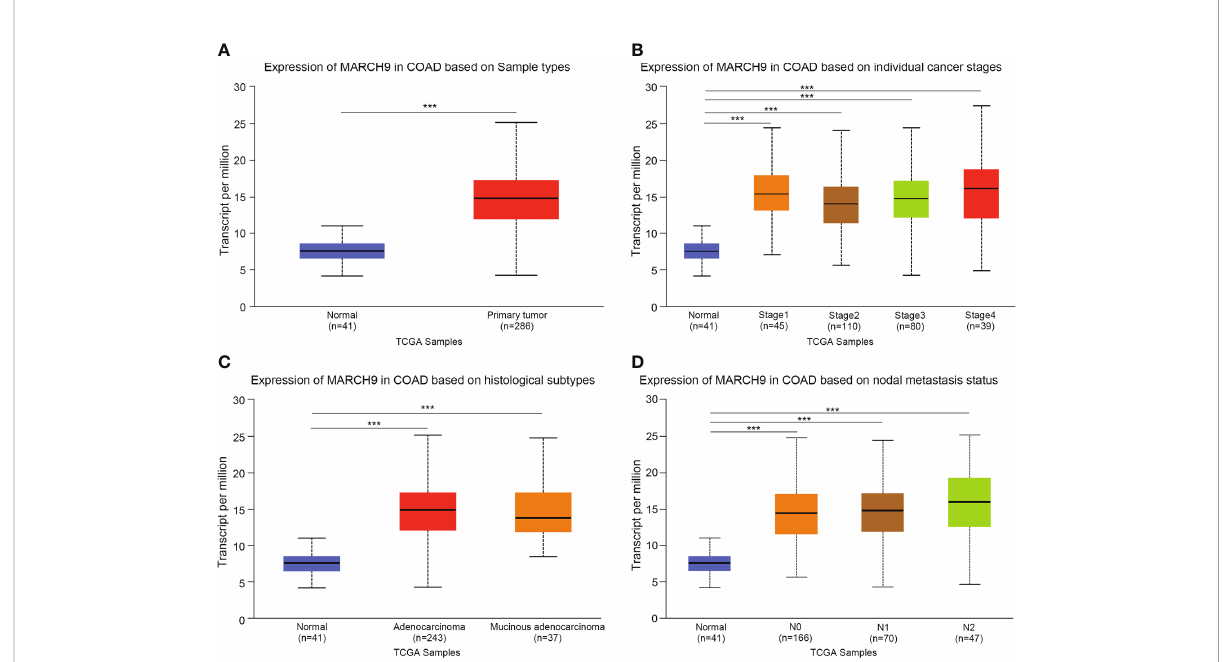
FIGURE 1 MARCH9 was highly expressed in CRC tissue. (A) Expression of MARCH9 in tumors vs normal controls. (B) Expression of MARCH9 in different cancer stages. (C) Expression of MARCH9 in different histological subtypes. (D) Expression of MARCH9 in nodal metastasis ***p<0.001.